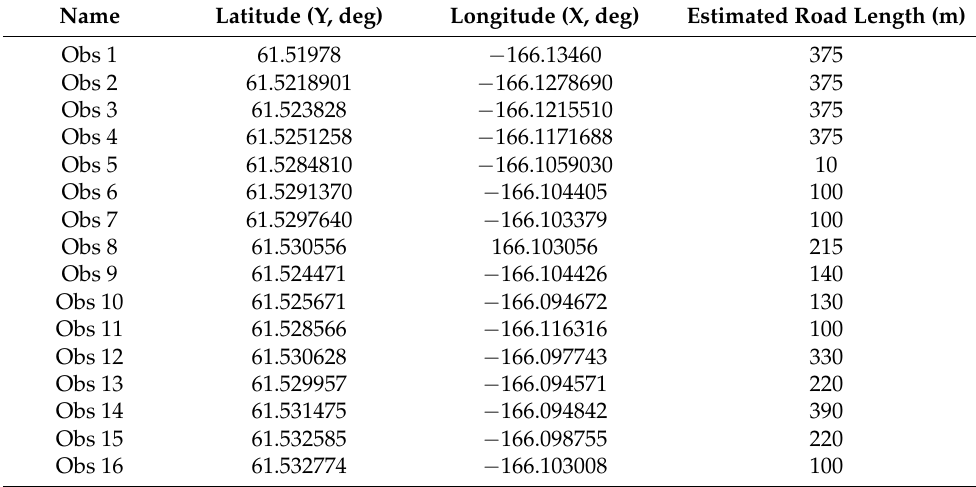
Table 3. Observation point